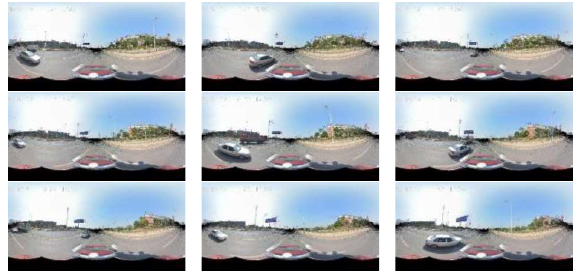
Figure 9 . The registration results of No.2-No.10 in dataset I